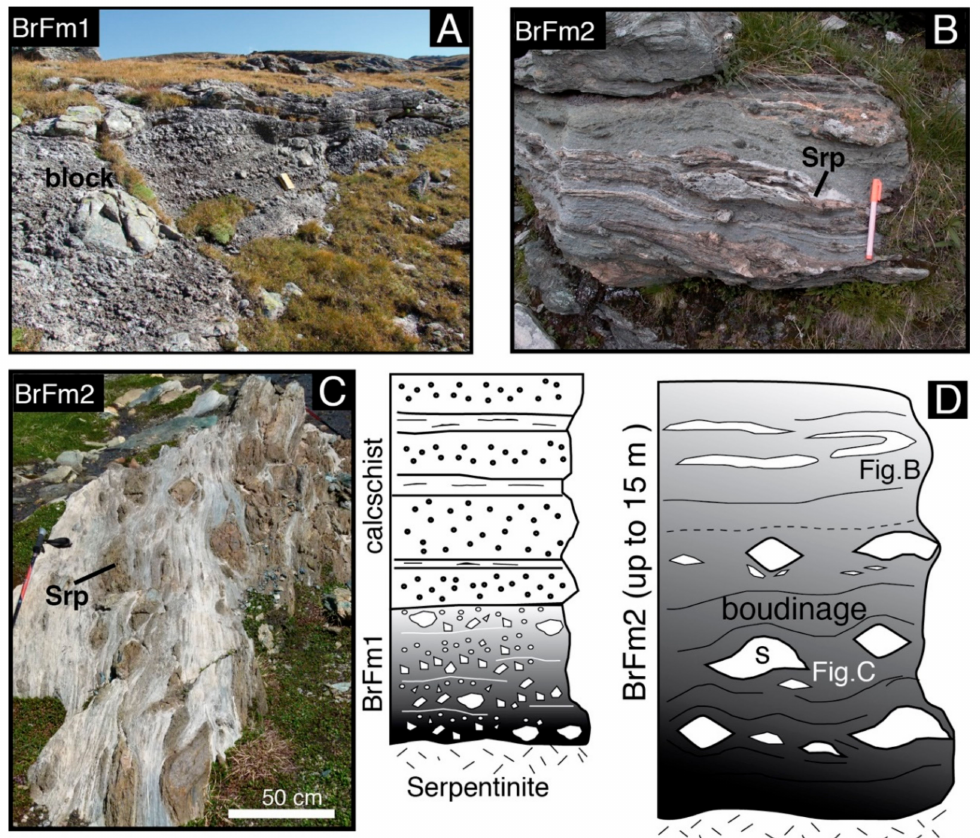
Figure 4. Outcrop views of Broken formation 1 (BrFm1) and Broken formation 2 (BrFm2) in the CCU of the high Champorcher valley. ( A ) BrFm1 outcrop exposed in the northwestern study area. It consists of clast- to matrix-supported ultramafic metabreccia with decimeter- to centimeter-sized clasts. Rare elongated or lense-shaped blocks up to 50 cm long (left side) may occur. At the outcrop scale, this unit is characterized by both normal and reverse internal grading. Notebook for scale. ( B ) BrFm2 outcrop showing disrupted horizons and clasts with ultramafic composition (covered by orange colored coating; Srp) embedded within a Cb-rich matrix. ( C ) View of the most common occurrence of BrFm2 characterized by a block-in-matrix fabric with boudinaged horizons, centimeter to decimeter thick, composed of ultramafic metasandstone (Srp), enveloped in an impure, white, or grey-colored matrix. Stick for scale. ( D ) Conceptual cartoon illustrating the internal fabric of the BrFm1 and BrFm2 units in relation with the surrounding